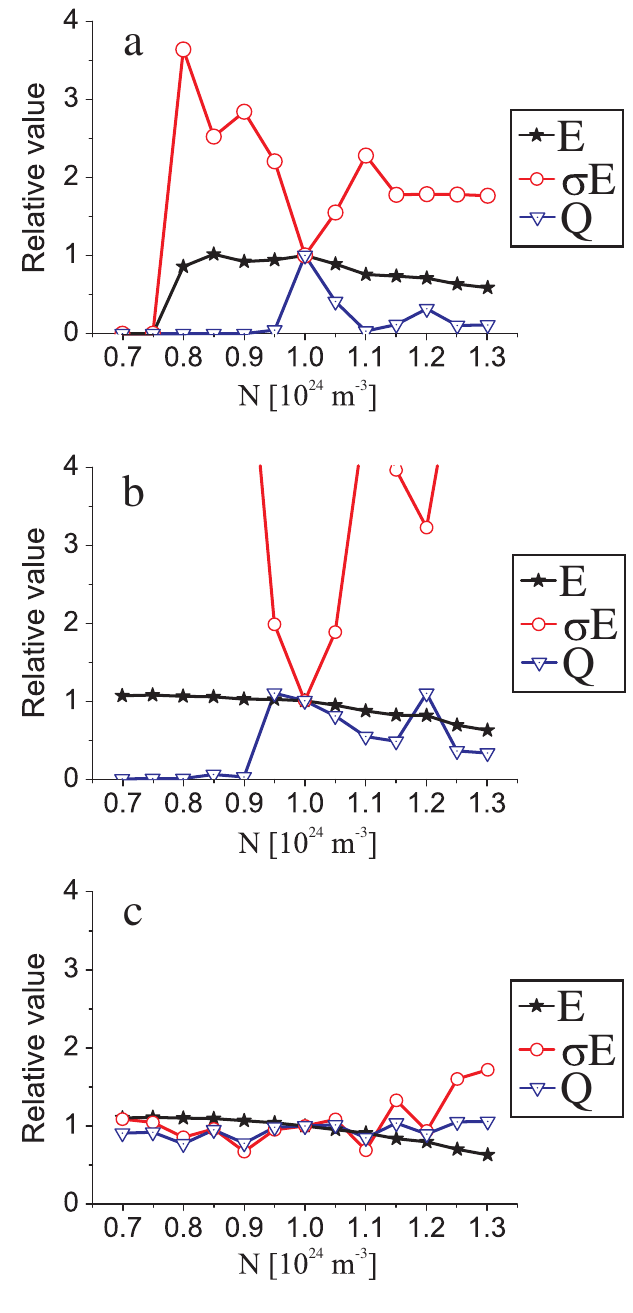
FIG. 13. (Color) Effect of (cid:1) 30% fluctuations in the plasma density on the final beam parameters [energy ( E ), energy spread ( (cid:5)E ), and trapped fraction ( Q )] for the different injection re- gimes: a 0 ¼ 0 : 32 (a), a 0 ¼ 0 : 56 (b), and a 0 ¼ 1 : 02 (c) with injection 300 fs in front of the laser